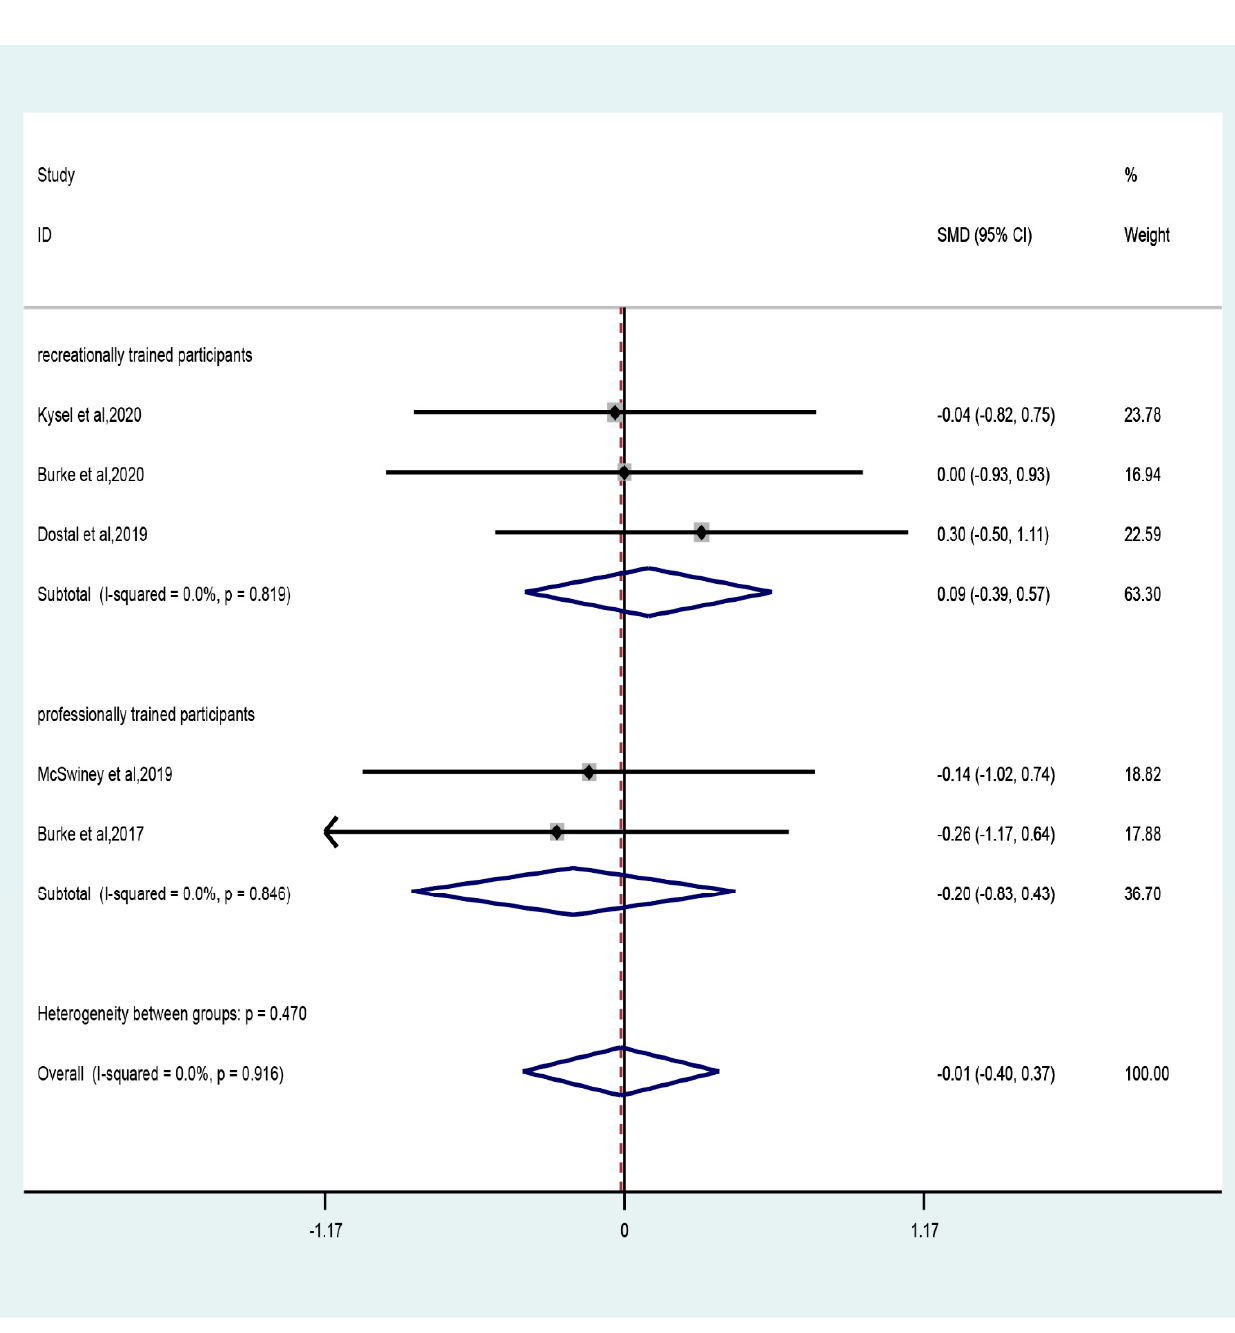
Figure 4. Forest plot of the effect of CT combined with LCHF on VO 2max in recreationally trained or professionally trained participants [26,31,32,47,50].